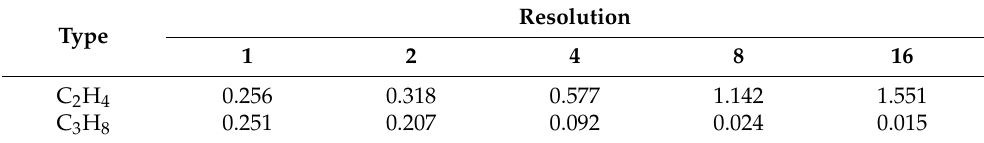
Table 7. The Allan deviation of quantitative analysis results under different spectral